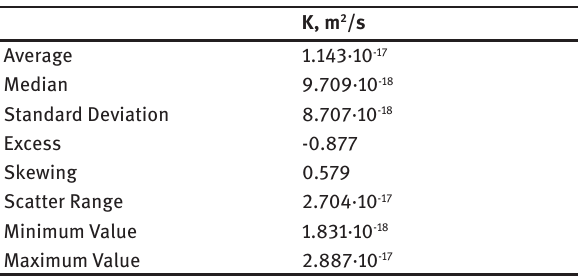
Figure 2: The effect of particle radius on the required time to reach the desired conversion (K = 1.143·10 -17 m 2 /s).